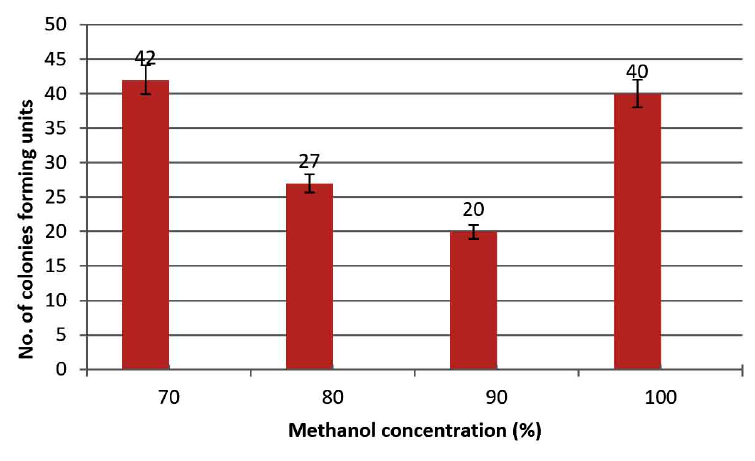
Fig. 4. Number of colonies forming units (CFU) on agar plate resulted from growth of B. thuringiensis spores after spreads 0.1 ml of spore suspension from surgical tools treated with Methanol solution.